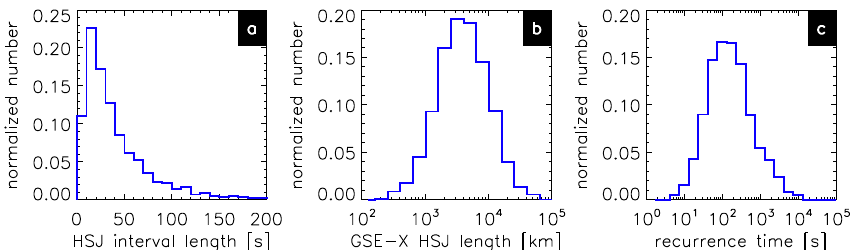
Fig. 4. Scale lengths of HSJs: distributions of (a) temporal lengths of HSJ intervals, (b) spatial lengths in GSE x direction given by the integral of v msh ,x over the HSJ interval, and (c) recurrence time, i.e., time between any two subsequent HSJs within a common magnetosheath interval.